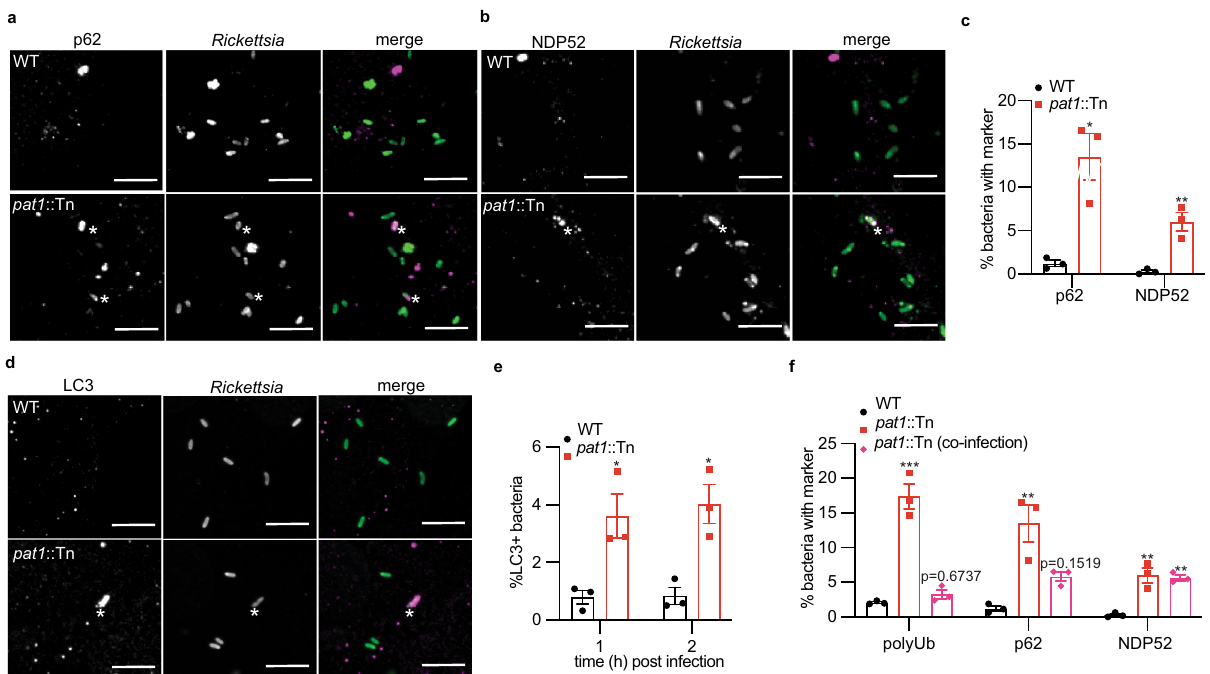
Fig. 4 Pat1 enables evasion of recognition by autophagy. Images of autophagy receptors a NDP52 (left; magenta in merge) and b p62 (right; magenta in merge) in WT and pat1 ::Tn (green in merge) infected HMECs. Asterisk denotes colocalization between bacterium and p62 or NDP52. Scale bars in ( a , b ) 5 µ m. c Quanti fi cation of ( a ) and ( b ), percentage of bacteria staining for NDP52 or p62 at 1 hpi (>1000 bacteria counted per strain for each marker), MOI 3. Data are mean ± SEM; ** p = 0.0060, * p = 0.0354 relative to WT (unpaired t -test (two-tailed)). d Images of LC3 (magenta) in HMECs infected with WT and pat1 ::Tn bacteria (green) at 1 hpi. Asterisk denotes colocalization between bacterium and LC3. Scale bars 5 µ m. e Quanti fi cation of percent bacteria staining for LC3 at 1 hpi (images in ( d )) and 2 hpi (images not shown), (>1500 bacteria counted per strain for each time point), MOI 3. Data are mean ± SEM; * p = 0.0244 (1 hpi), p = 0.0124 (2 hpi) relative to WT (unpaired t -test (two-tailed)). f Percentage colocalization of bacteria with polyUb, NDP52, and p62 in HMECs infected with WT, pat1 ::Tn mutant, or co-infected with WT and pat1 ::Tn mutant (>700 bacteria counted for each strain/ marker), MOI 5. For co-infections, quanti fi cation is for pat1 ::Tn bacteria only. Data are mean ± SEM; *** p = 0.0001, ** p = 0.0030 (p62), p = 0.0016 (NDP52, pat1 ::Tn), p = 0.0023 (NDP52, co-infection) relative to WT (one-way ANOVA with Dunnett ’ s post hoc test). All data represent n = 3 independent experiments. Source data are provided as a Source Data fi le.